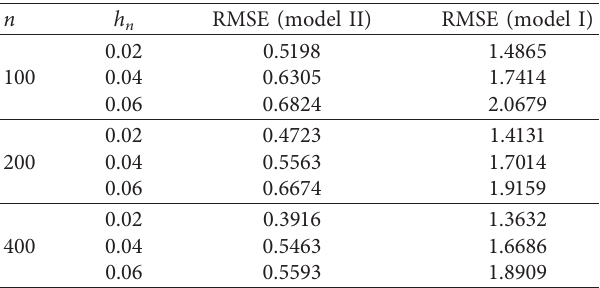
Figure 1: (a) Exacts and estimated values of f ( z Table 2: Values of the RMSE for Model I and Model II, with AR(1) innovations and 500